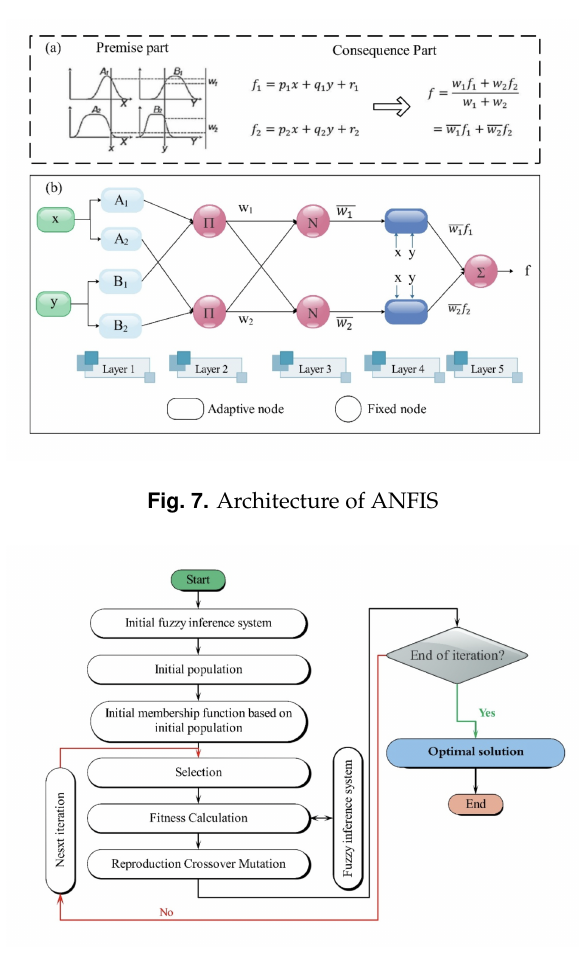
Fig. 8. The flowchart of hybrid ANFIS